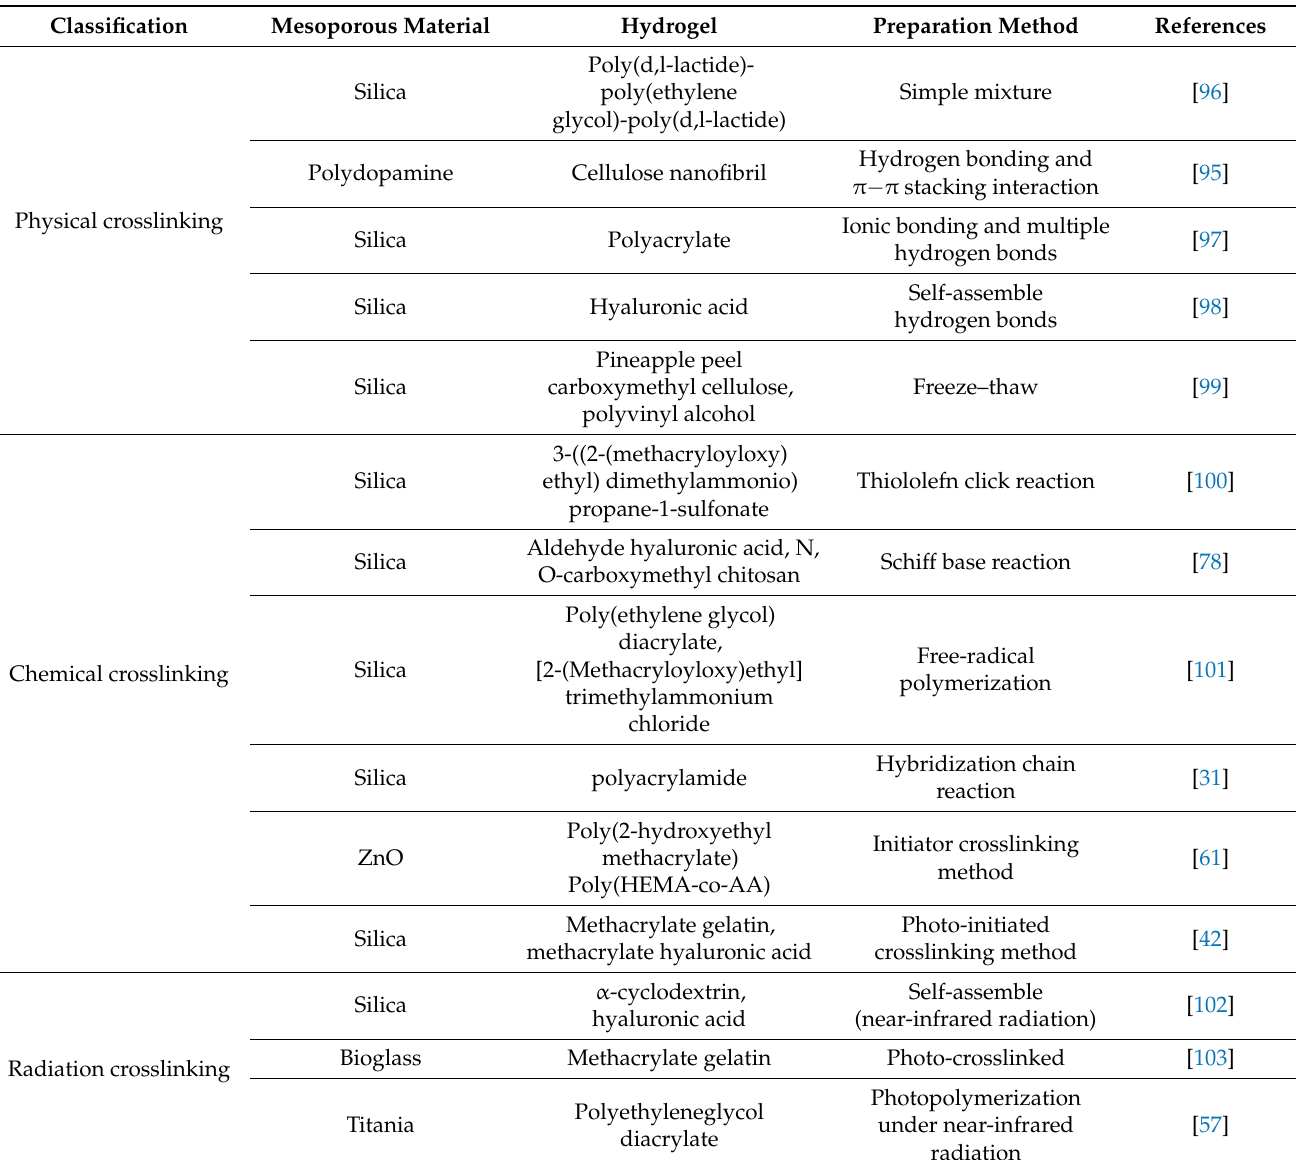
Table 2. Classification of preparation